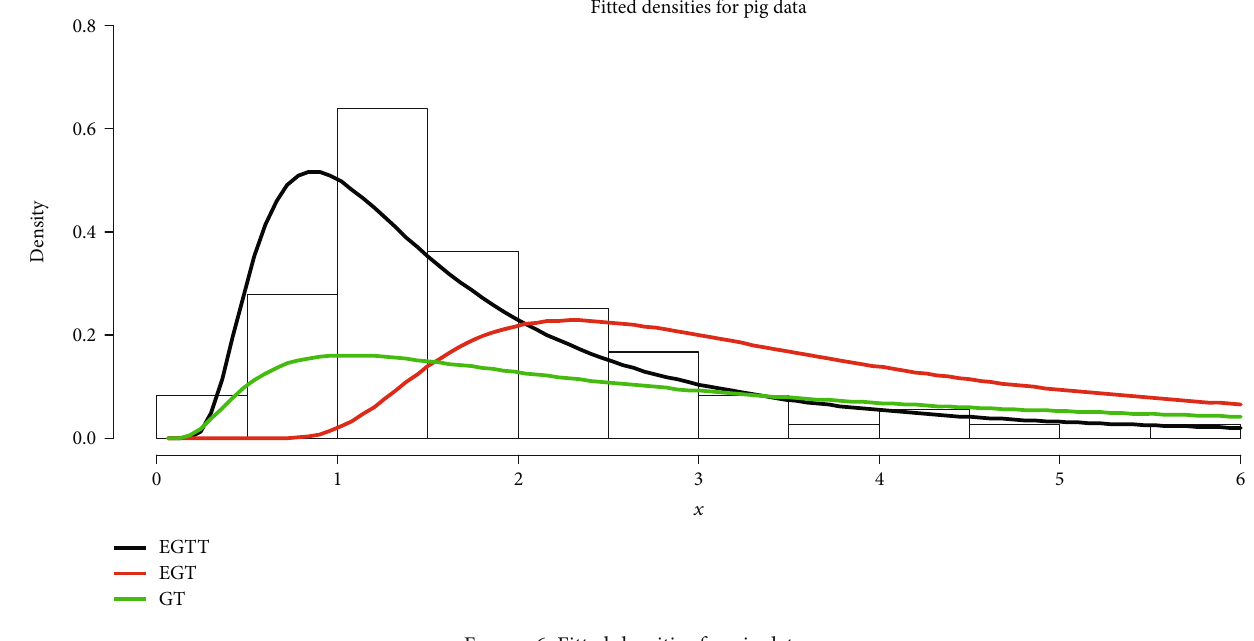
Figure 6: Fitted densities for pig data. Table 5: Parameter estimate and standard error (parenthesis) for cancer data.